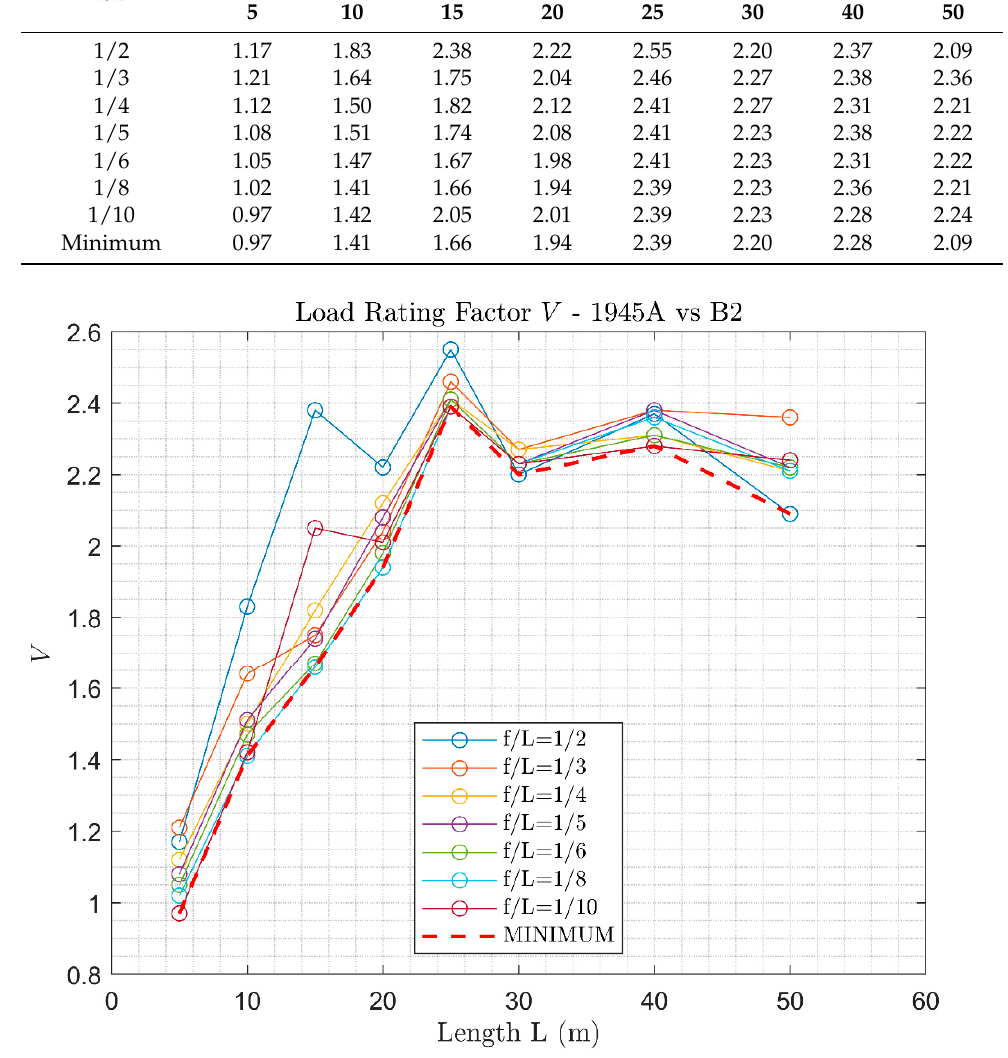
Figure 9. Reserve capacity of arches designed according to the 1945A code and verified with the B2 load.